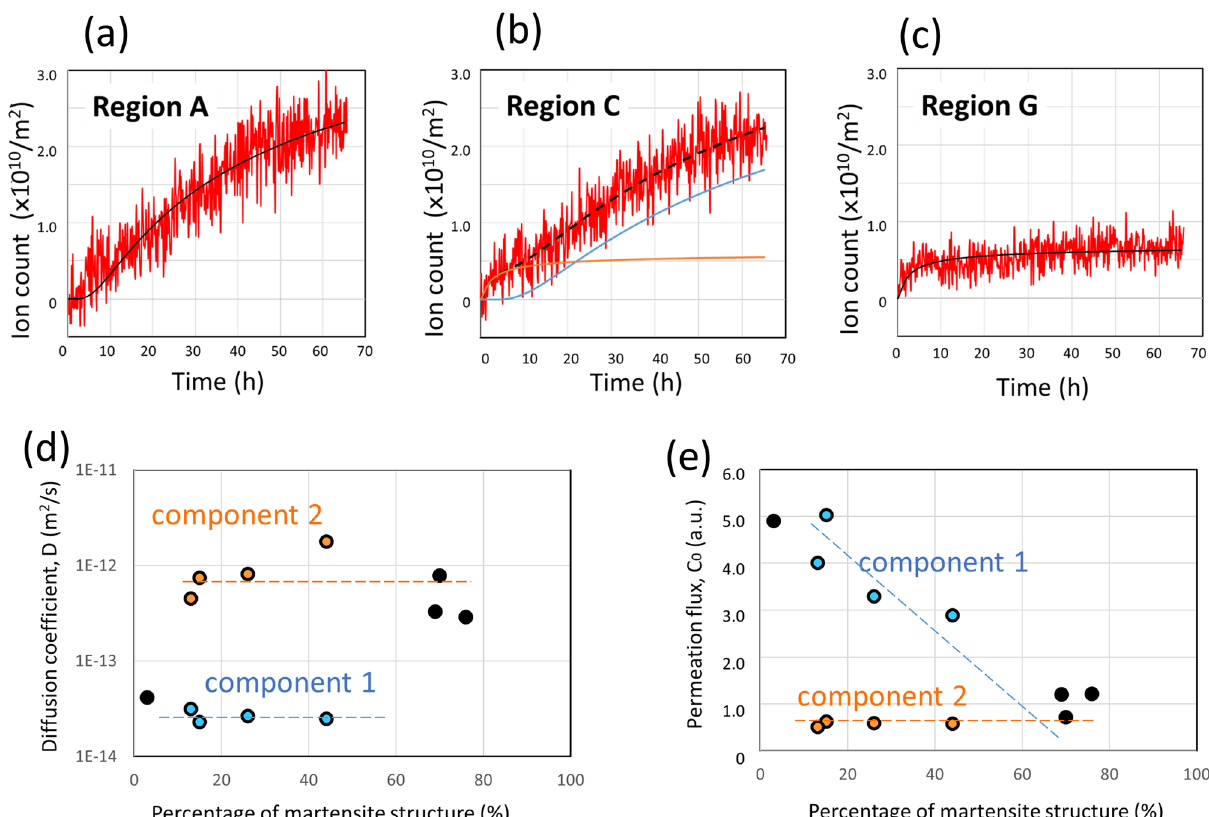
Figure 3. Ion counts plotted against time in each region. Counts are calibrated to the number per unit area. ( a ) Time evolution of ion counts desorbed in region A. The region size of ion counting was 5.3 × 10 −9 m 2 , and 97% of the structure was austenite and 3% was martensite. ( b ) Time evolution of ion counts desorbed in region C. The region size was 6.4 × 10 −9 m 2 , austenite and martensite structures accounted for 85% and 15%, respectively. ( c ) Time evolution of ion counts desorbed in region G. The region size was 1.6 × 10 −8 m 2 , austenite and martensite structures were 30% and 70% respectively. Solid black lines in ( a ) and ( c ) are curves fitted using Fick’s law. Only the ion count line in ( b ) can be resolved into two fitting components. Component 1 (blue line) had a slow diffusion speed and component 2 (orange line) had faster one. ( d ) Diffusion coefficients of hydrogen in the eight local regions derived from the fitting results. They are plotted as a function of the ratio of martensite structure in each region. Solid black circles are single fitted results, such as shown in ( a ) and ( c ). Blue and orange circles are from resolved Component 1 and Component 2, such as in ( b ). ( e ) Permeation fluxes determined by fitting curves, which are the permeation fluxes after reaching steady-state hydrogen permeation, from the 0.1 MPa hydrogen compartment to the vacuum compartment through the 100 µm sample. For visual assistance, the features of Component 1 and Component 2 are marked with dashed lines, in ( d ) and ( e